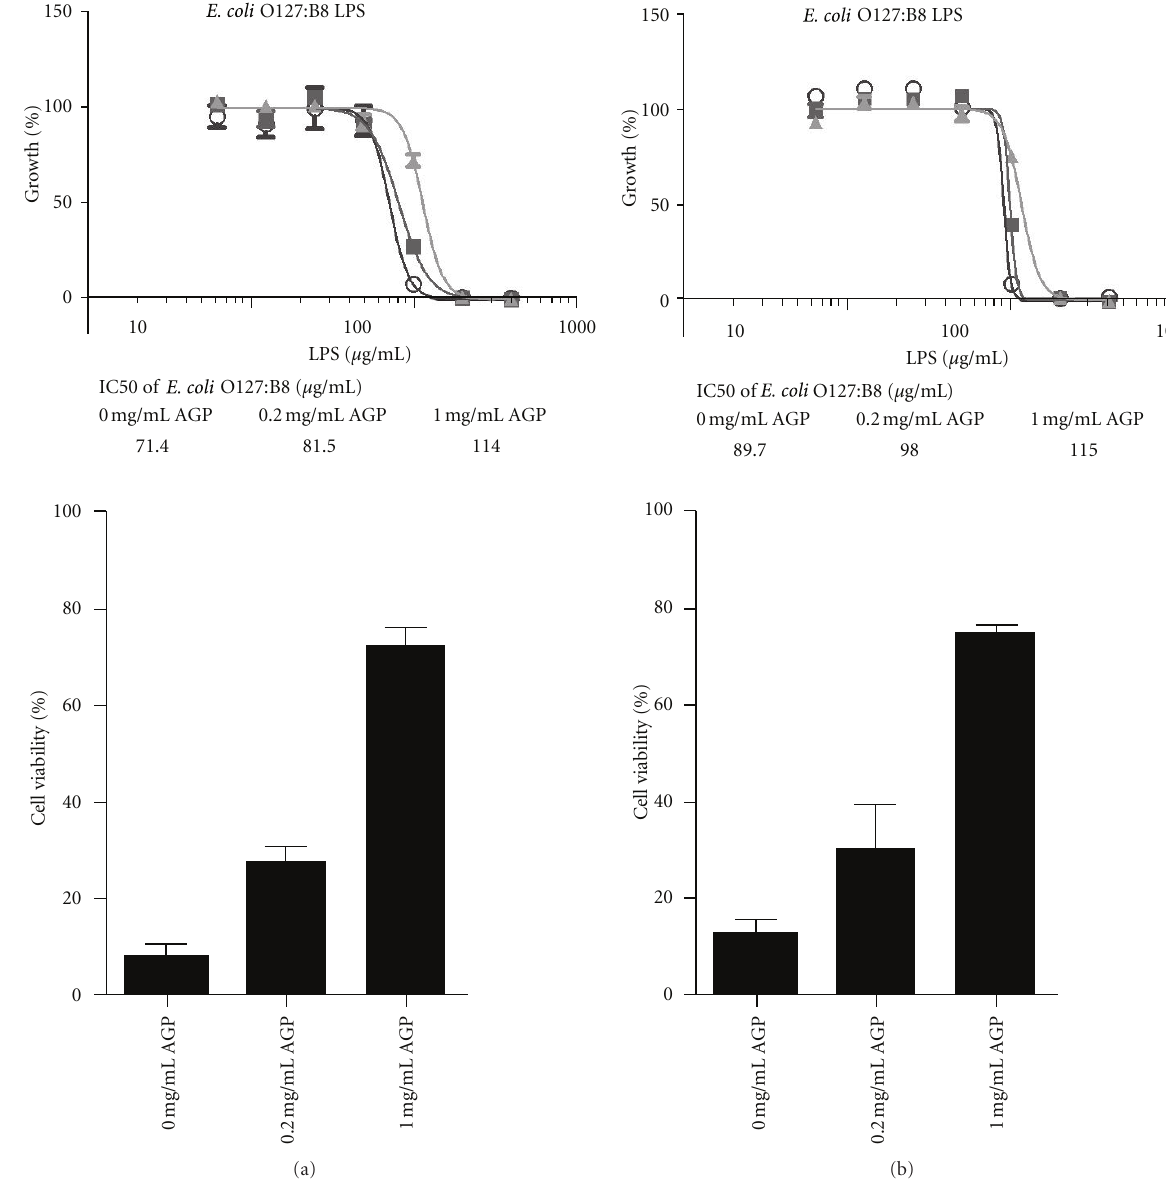
Figure 5: The protective e ff ect of AGP against LPS-induced cytotoxicity in HEK293 cell culture. (a) Top panel. The percentage of cell growth in the presence of increasing concentrations of E. coli O127:B8 LPS. ( (cid:8) ) 0mg/mL AGP; ( (cid:3) ) 0.2 mg/mL AGP; ( (cid:4) ) 1mg/mL AGP. Bottom panel. The percentage of cell viability upon exposure to 100 μ g/mL E. coli O127:B8 LPS, in the presence and absence of AGP. (b) Top panel. The percentage of cell growth in the presence of increasing concentrations of E. coli O111:B4 LPS. ( (cid:8) ) 0 mg/mL AGP; ( (cid:3) ) 0.2 mg/mL AGP; ( (cid:4) ) 1mg/mL AGP. Bottom panel. The percentage of cell viability upon exposure to 100 μ g/mL E. coli O111:B4 LPS, in the presence and absence of AGP. The inset table documents the IC50 values for LPS in the presence of increasing AGP